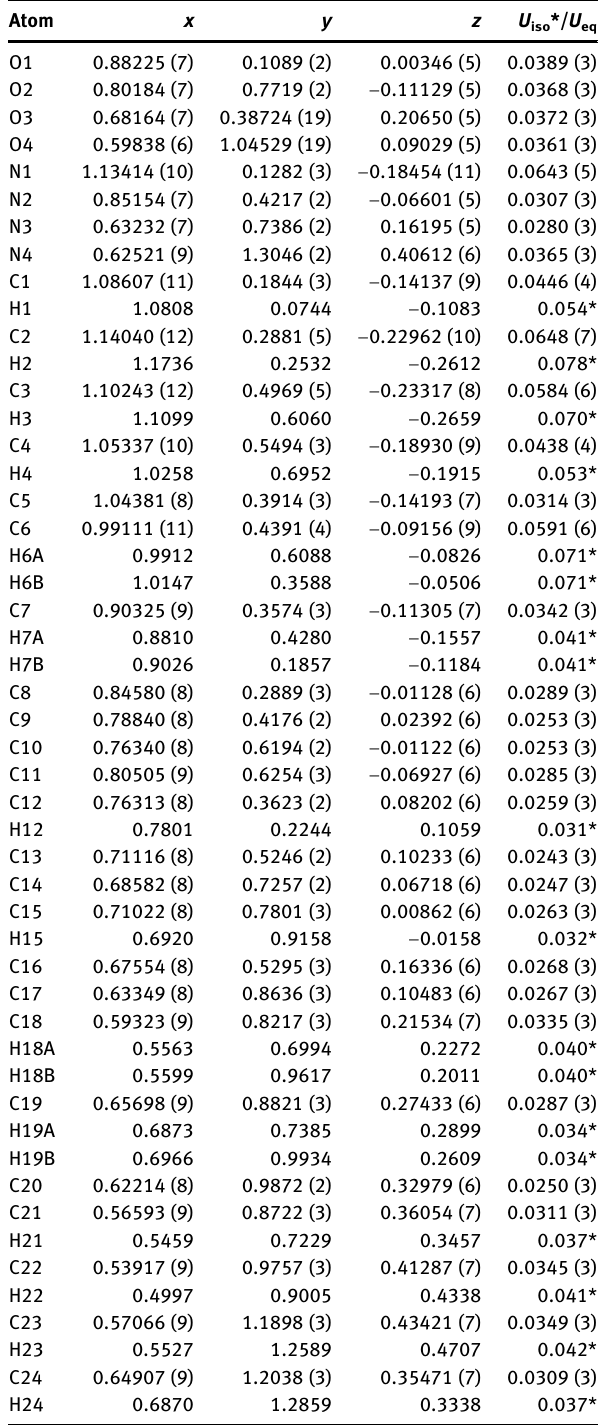
Table  : Fractional atomic coordinates and isotropic or equivalent isotropic displacement parameters (Å 